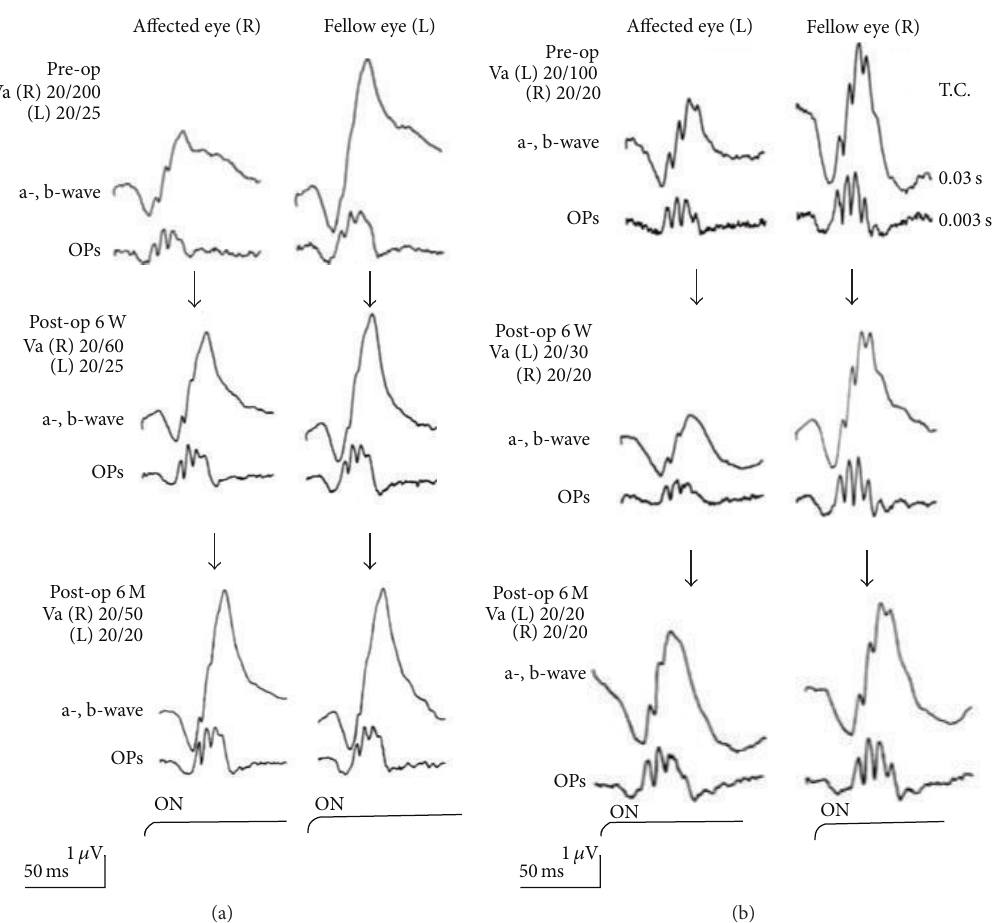
Figure 4: (a) Focal macular ERGs before and 6 weeks and 6 months after IMH surgery without ILM removal and the fellow eye. The b-wave amplitudes increase 6 weeks and even further 6 months after surgery. (b) Focal macular ERGs before and 6 weeks and 6 months after IMH surgery with ILM removal and the fellow eye. The b-wave amplitudes are significantly decreased 6 weeks after surgery but recover 6 months after surgery to the same level as that prior to surgery [7].